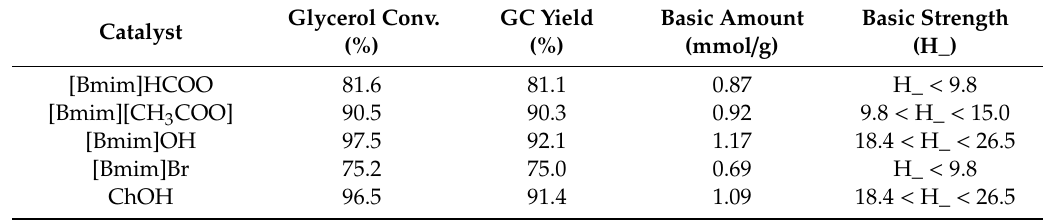
Table 1. E ff ect of ionic liquid basicity on glycerol conversation and carbonate glycerol (GC) yield.